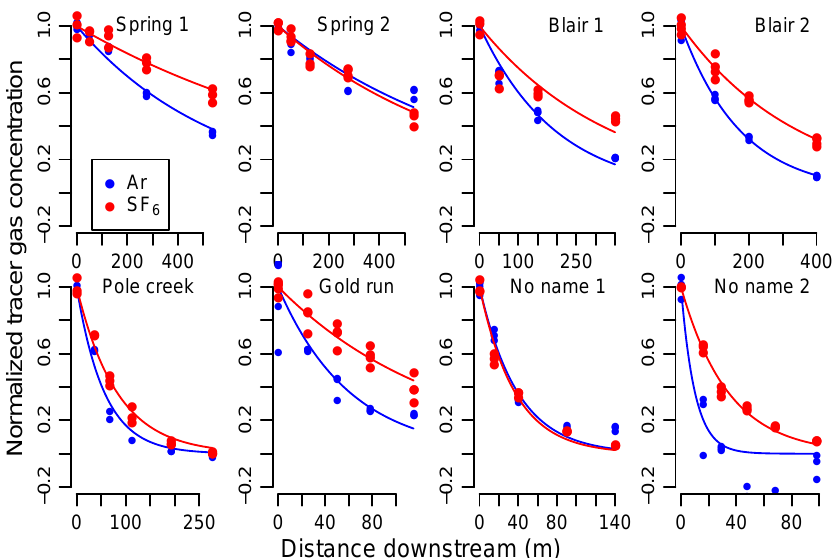
Figure 2. Exponential decline of normalized argon and SF 6 at each downstream sampling site for each stream shows that rates of decline for SF 6 (blue) are lower than that for Ar (red). Points are normalized tracer gas concentrations, An x and Sn x , and lines are exponential model fits (Eq.